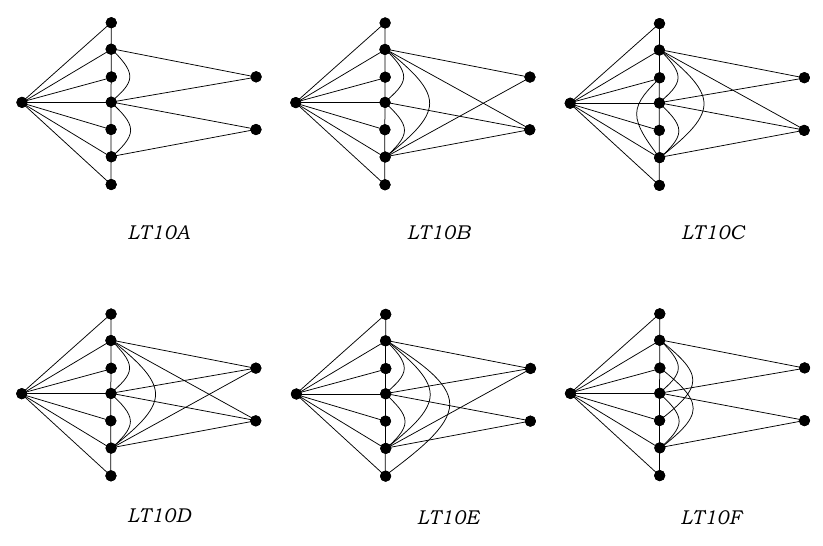
Fig. 6: The nontraceable LT graphs of order